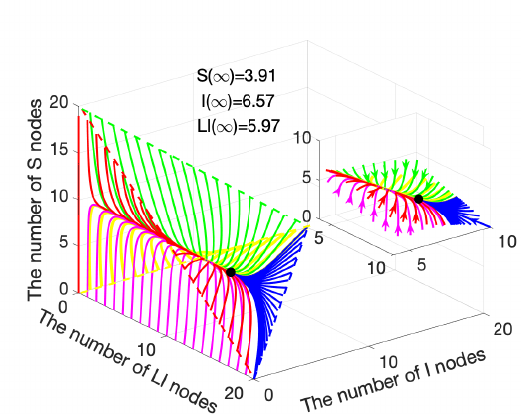
Figure 5. Variation of S, I and LI nodes when R 0 >